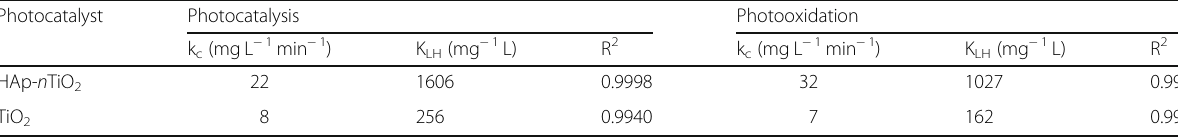
Table 3 Langmuir-Hinshelwood parameters of MV photocatalysis and